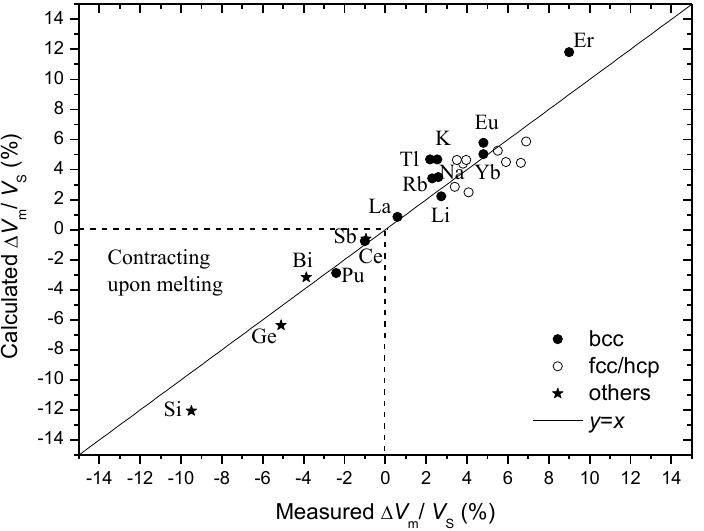
Figure 4. Agreement of calculated and measured volume changes on melting for Si, Ge, Bi, Sb, Pu, Ce, La, Tl, Eu, Yb, Er as compiled in Table 2. Data reported in Ref. [29] are also shown for reference (open